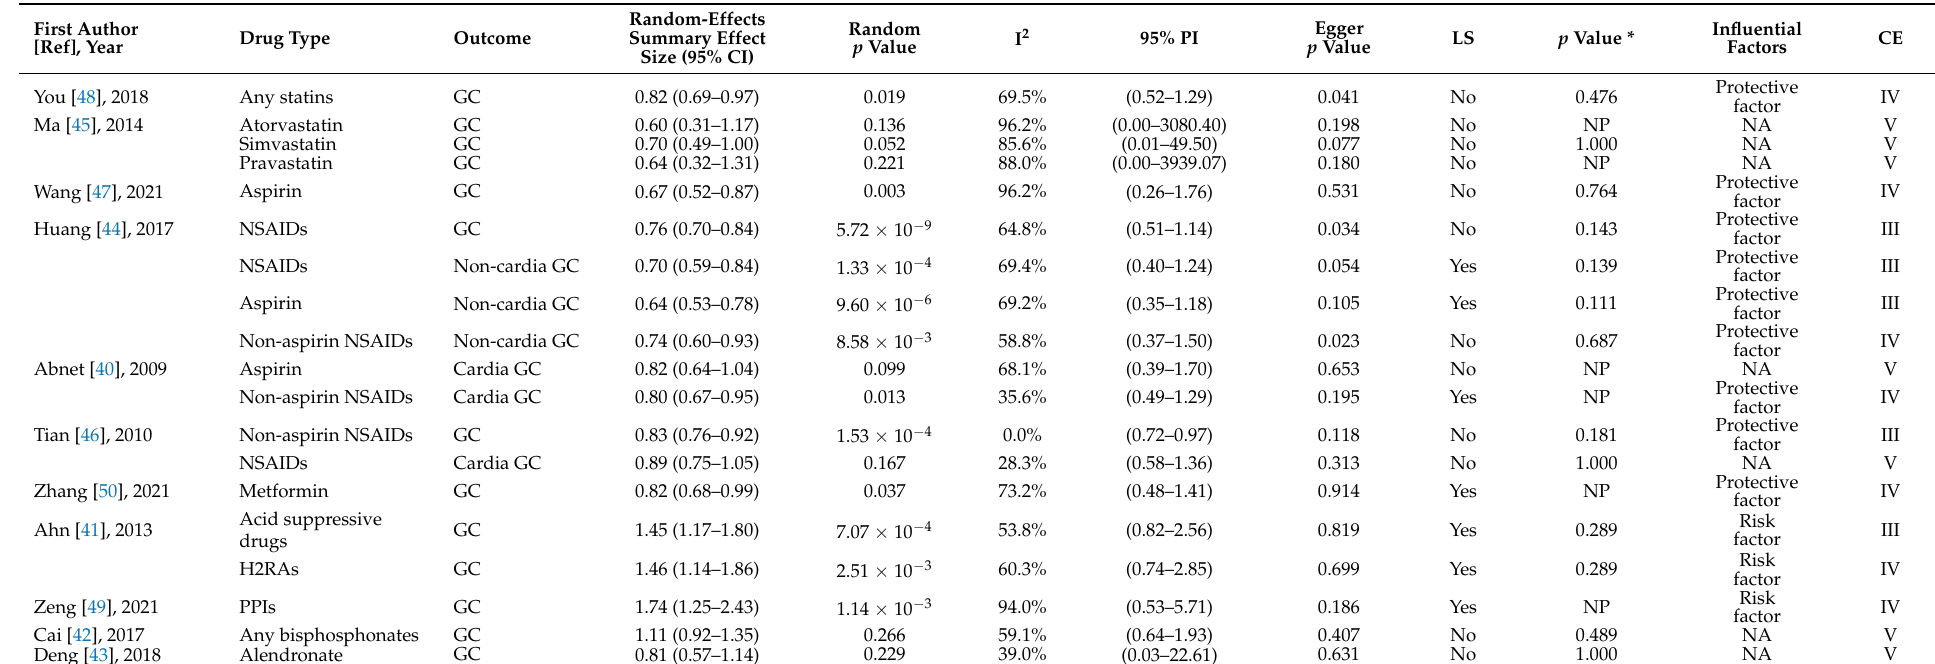
Table 2. Evidence-rating results on associations between commonly used drugs and the risk of gastric